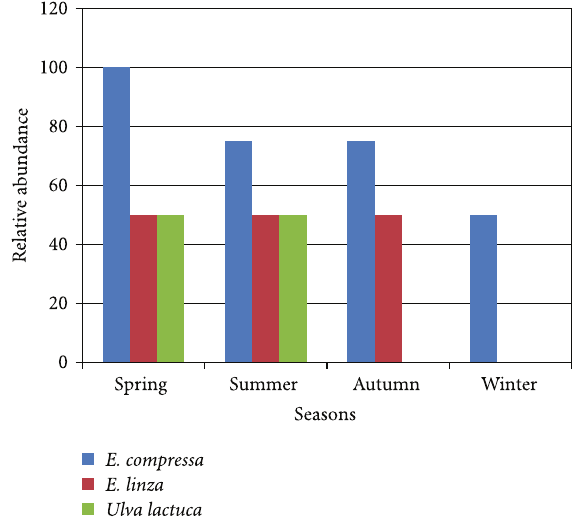
Figure 1: % abundance of green macroalgal species collected at di ff erent seasons from Abu Qir